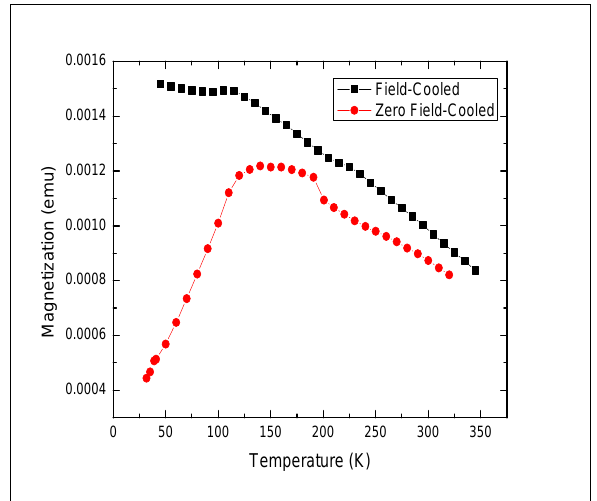
O nanocrystals. Magnetization 3 4 = 100 m